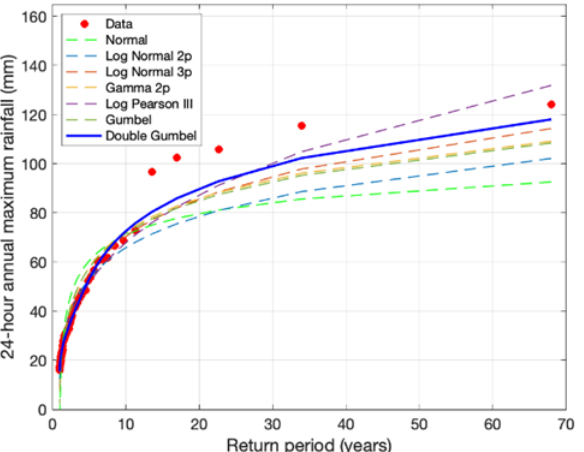
Figure 5. Fitting the distribution functions to the data of maximum daily rainfall in 24-h in the function of the return period.